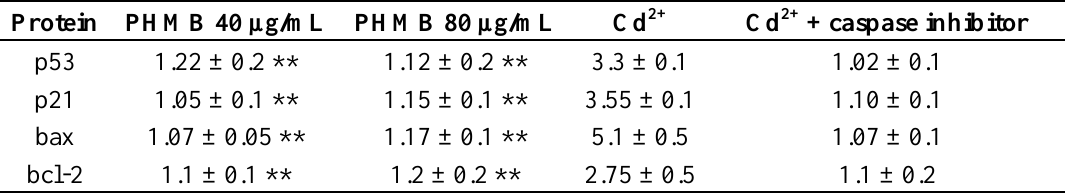
Table 9. Relative values of p53 , p21 , bax , and bcl-2 proteins in Neuro - 2A cells incubated with PHMB for 24 h. Measurements were done using the Koma-ELISA kit (Japan). Plates were pretreated with anti-mouse antibodies. Values are expressed as mean ± SEM without